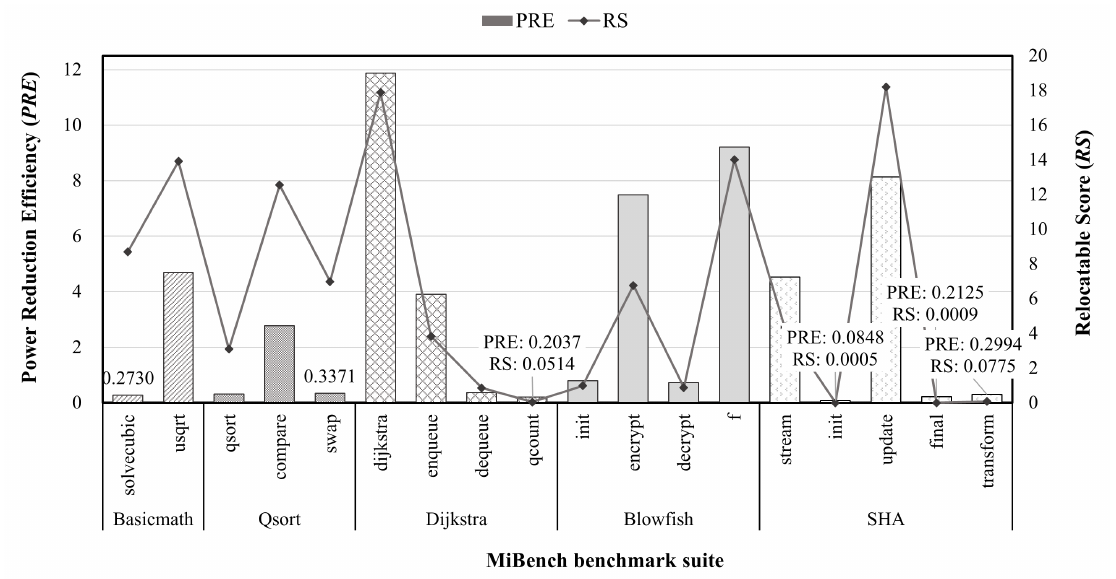
Figure 10. Power Reduction Efficiency (PRE) value and Relocatable Score (RS) value